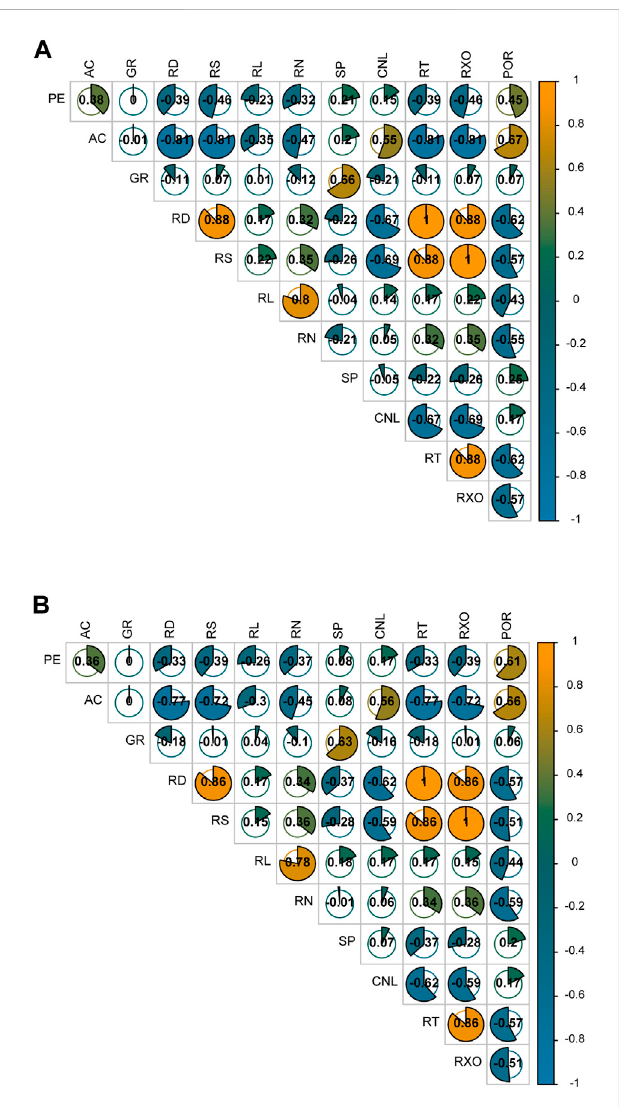
FIGURE 6 (A) is algorithm correlation heat map based on Pearson between the various parameters (B) is algorithm correlation heat map based on Spearman between the various